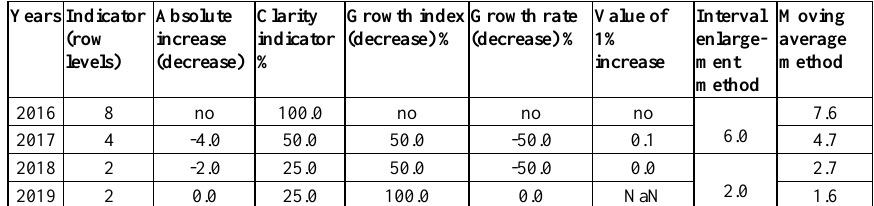
Table 5. Attendance dynamics in the control group